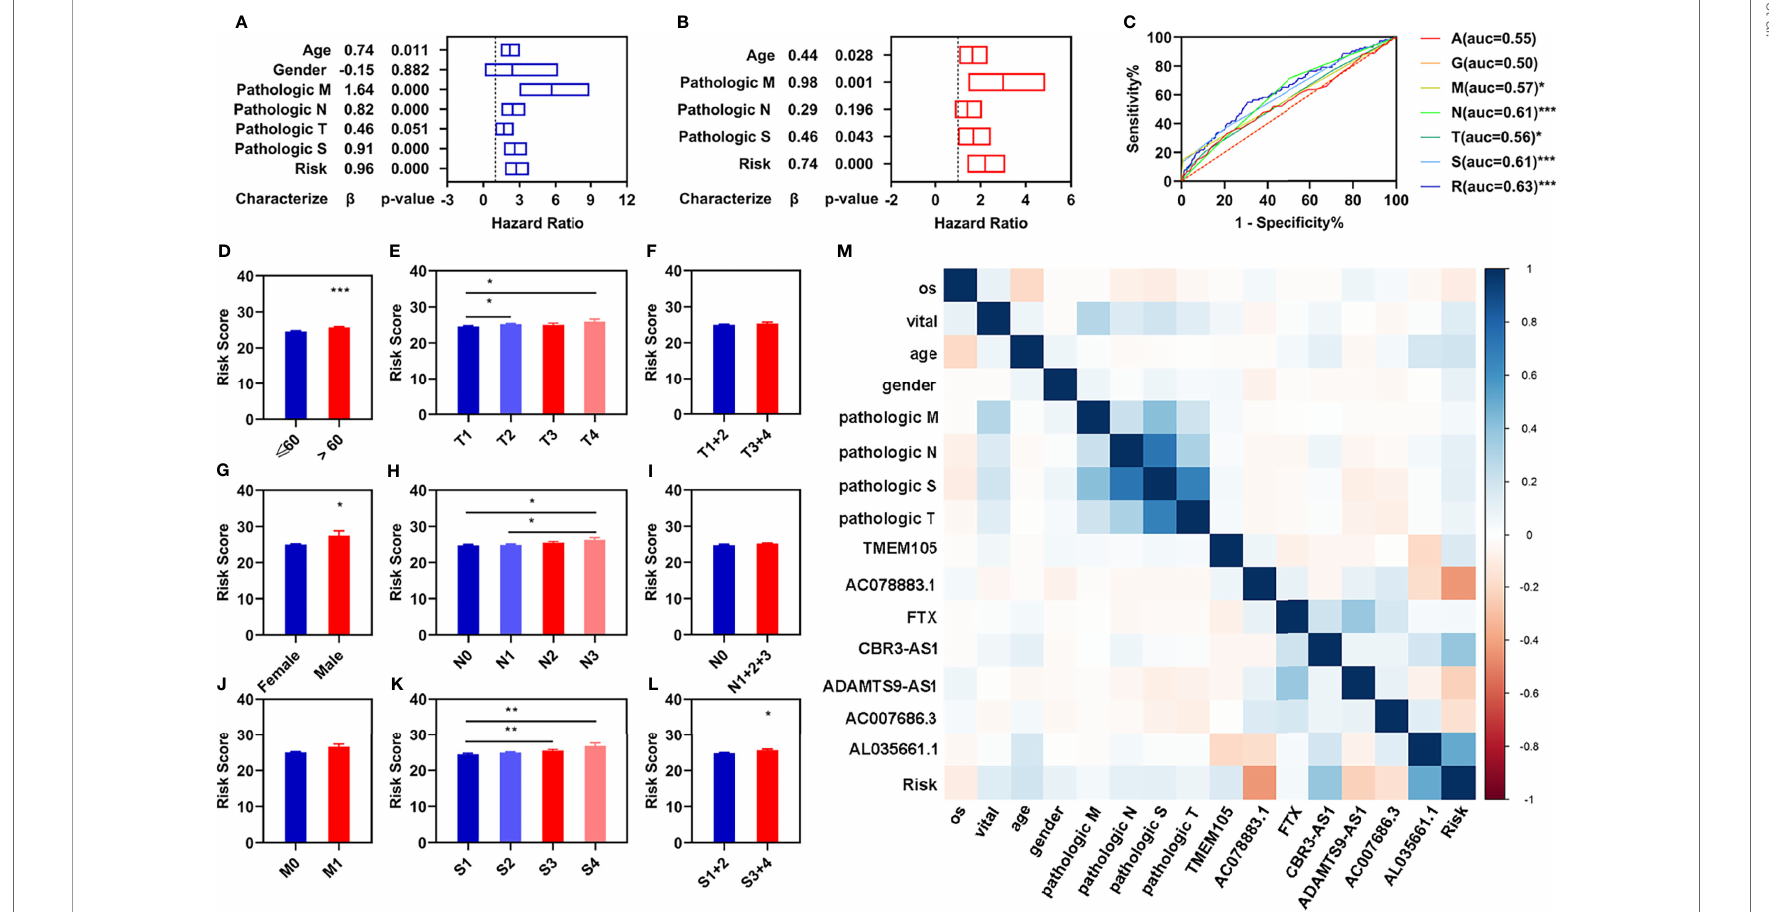
FIGURE 3 | Independent prognostic values of these four FI-DELs. (A) Univariate Cox regression analyses illustrated four clinical characteristics and risk assessment model were correlated with OS of patients. (B) Multivariate Cox regression analyses illustrated that three clinical characteristics and risk assessment model were correlated with the OS of patients independently. (C) ROC curve of different clinical characteristics and risk assessment model. (D – L) Comparison of the risk score in different clinical characteristics groups. (M) Correlation analyses of these seven FI-DELs with the clinical characteristics. *p < 0.05, **p < 0.01, ***p <